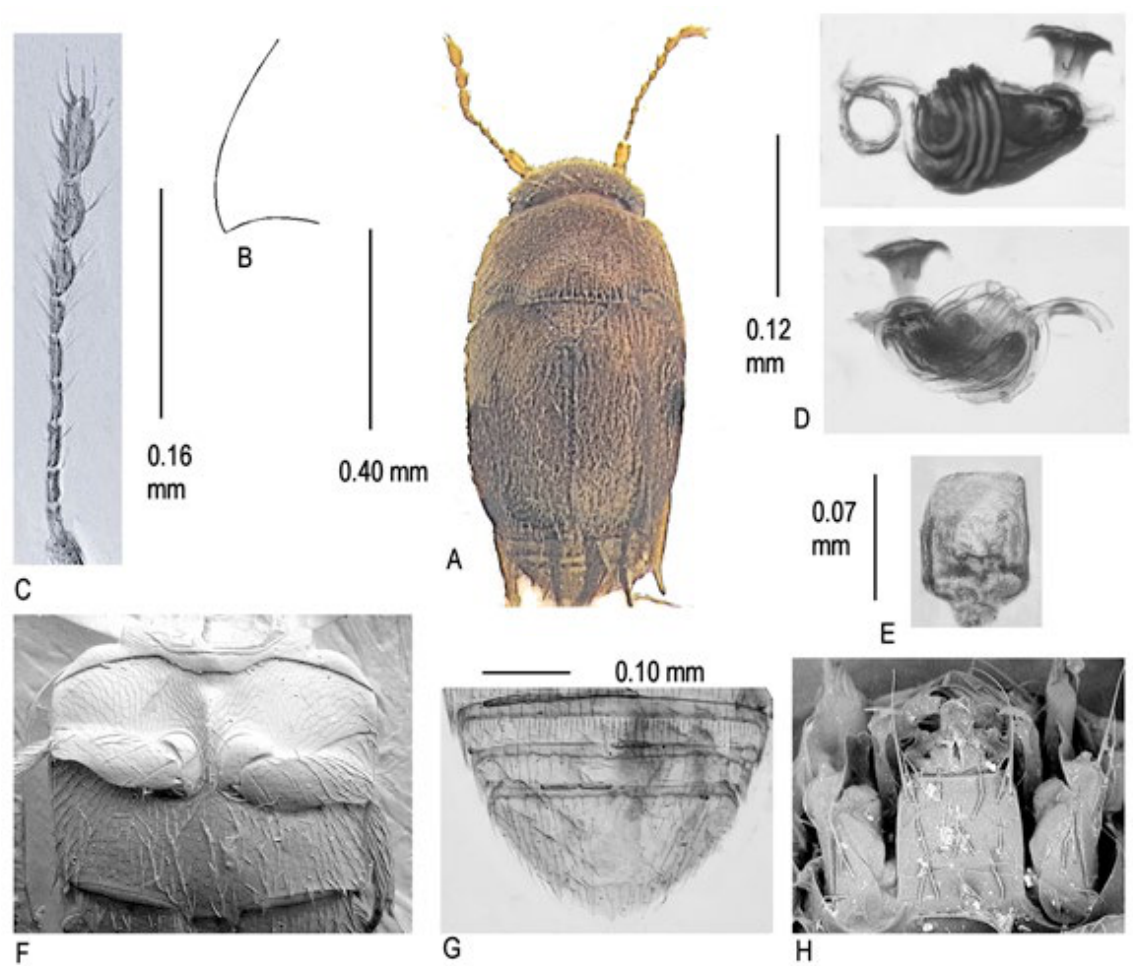
Fig. 18. Acrotrichis geiseri sp. nov. A . Habitus. B . Hind angle of pronotum viewed at 45°. C . Antennomeres III–XI. D . Spermatheca. E . Aedeagus. F . Meso- and metaventra ×355. G . Pygidium. H . Mentum and submentum